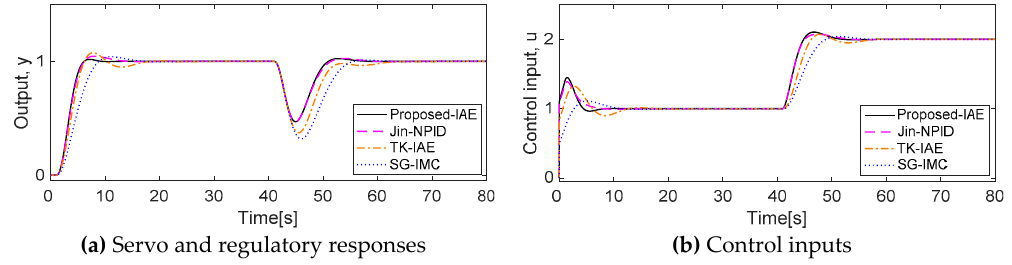
Figure 9. Servo and regulatory responses for nominal process 2. Table 5. Quantitative comparison of performances for nominal process 2.